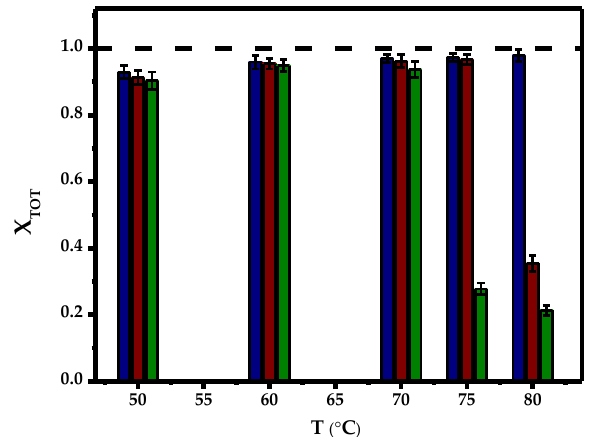
Figure 5. Equilibrium conversion of ibuprofen during its esterification with glycerol at all tested temperatures and initial concentrations of ibuprofen (20 g·L −1 (blue), 60 g·L −1 (red) and 100 g·L −1 (green)).